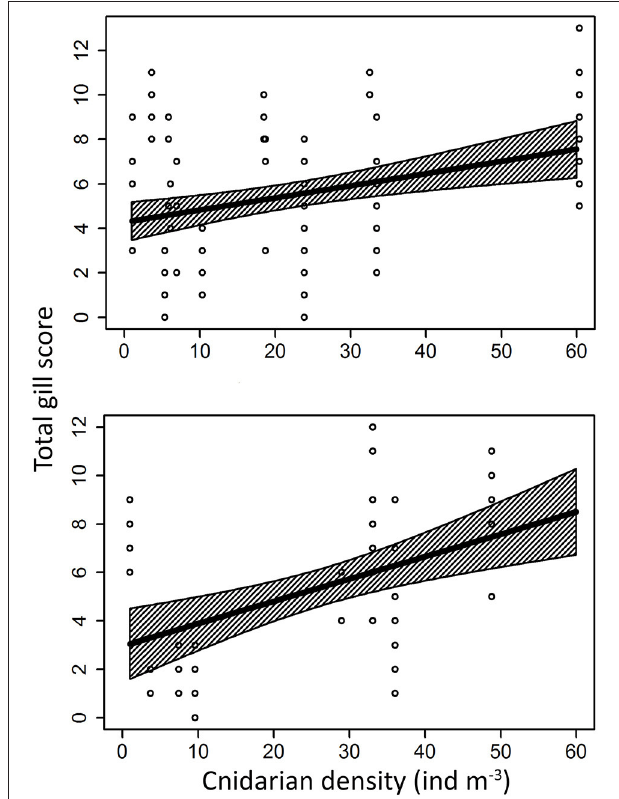
FIGURE 7 | Generalized linear model between total gill score and cnidarian density for the Almería facility (above) and the Málaga fish farm